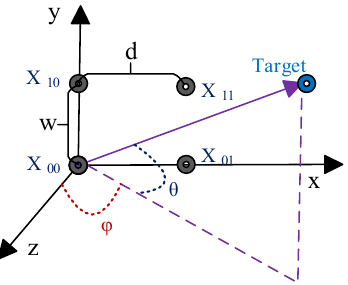
Figure 1. Configuration of a four-channel PCM antenna.